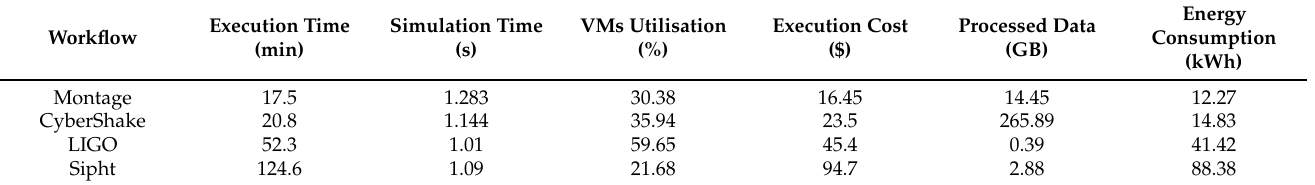
Table 8. The experimental results for DISSECT-CF-Fog with different scientific workflow